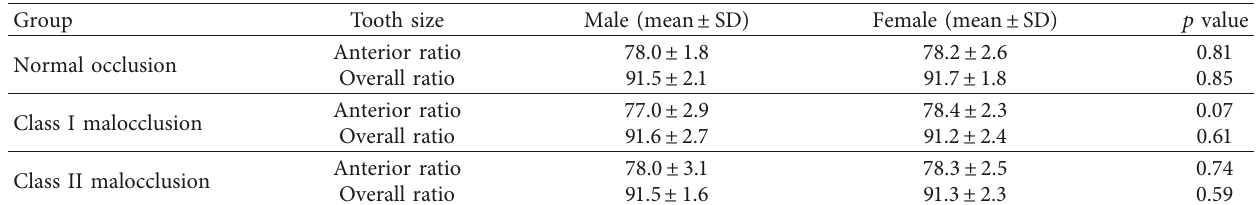
Table 3: Independent T -test for comparison of tooth size between males and females of different groups. Group